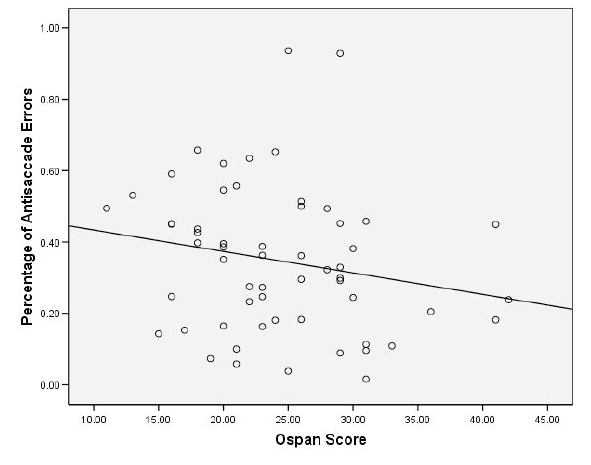
Figure 3. Correlation of Ospan scores and antisaccade errors. Participants were split on the basis of their ospan scores into two groups, (high vs low working span).